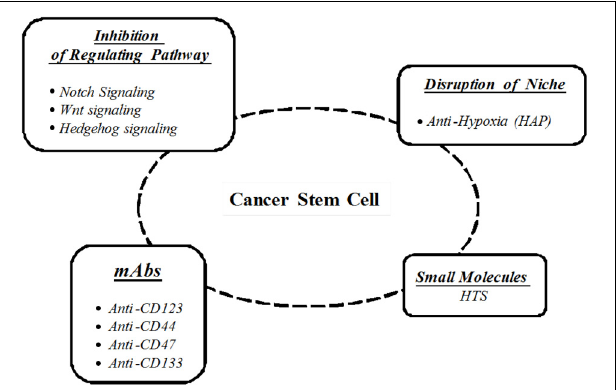
FIGURE 1 | Cancer stem cells targeting